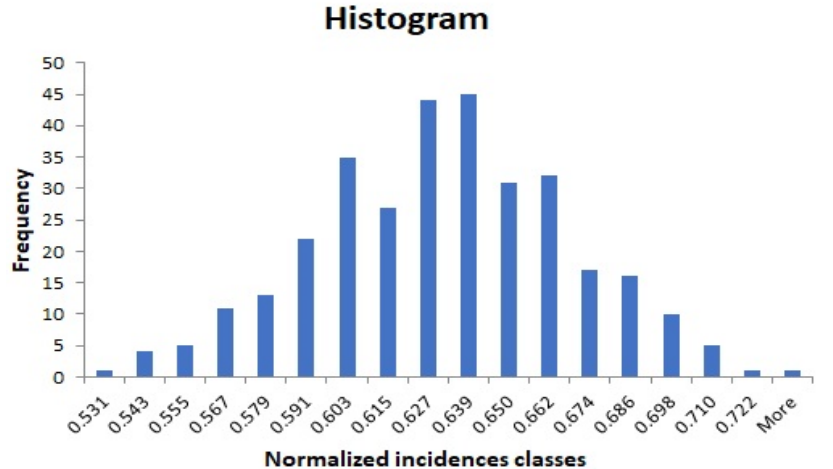
Figure 5. Superposition of 10 randomly generated 𝑅 (cid:3047)(cid:3040) curves. Each 𝑅 (cid:3047)(cid:3040) curve was generated on calculus based on a specific 𝐼𝑚 (cid:3047) series and applying (19). Following a Monte Carlo simulation pro- cess, the 𝐼𝑚 (cid:3047) series were calculated with the 𝐼 (cid:3047) series data generated by a random incidence series generator.